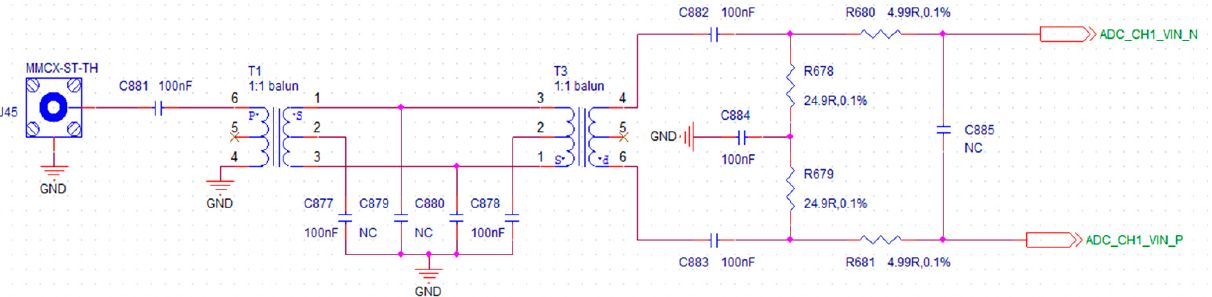
Figure 3. The analog front-end circuit diagram.